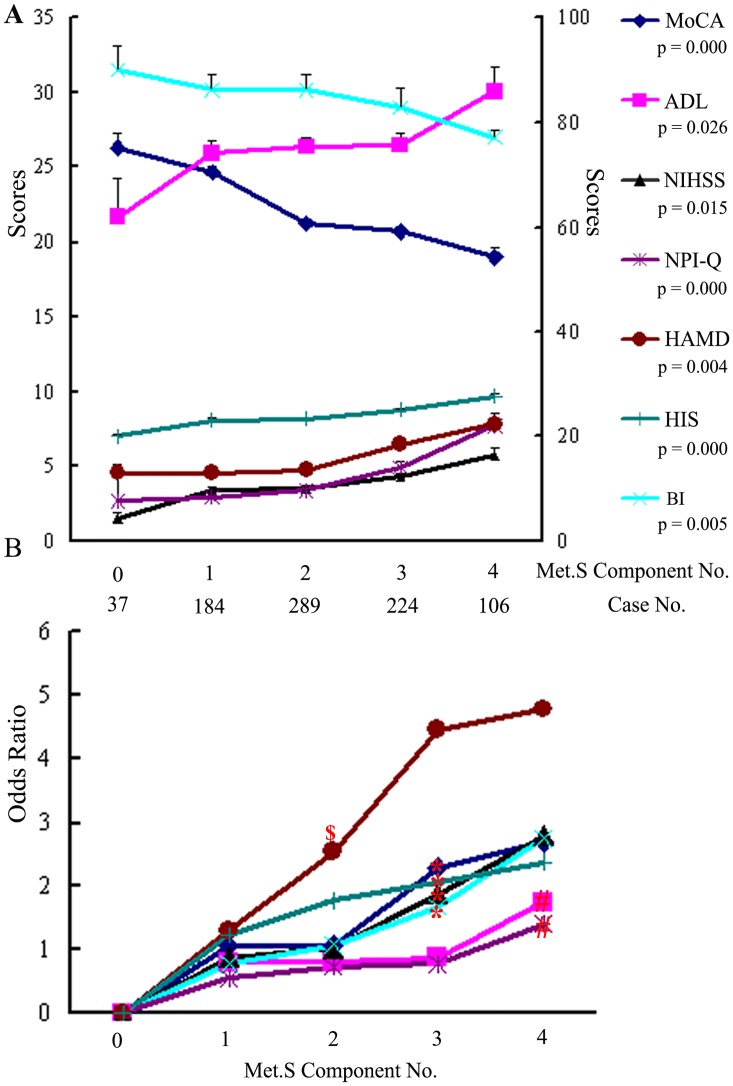
Stratified analysis of association between number of MetS risk factors and different neurological domains.(A) Test variable scores according to the number of MetS components. Data are mean±SD; ANOVA analysis. (B) OR for lower performance in the different neurofunctional tests according to the number of MetS components. Multinominal logistical regression for all values, $ indicates P<0.05 when the number of MetS components was two; * indicates P<0.05 when the number of MetS components was three; # indicates P<0.05 when the number of MetS components was four or more.